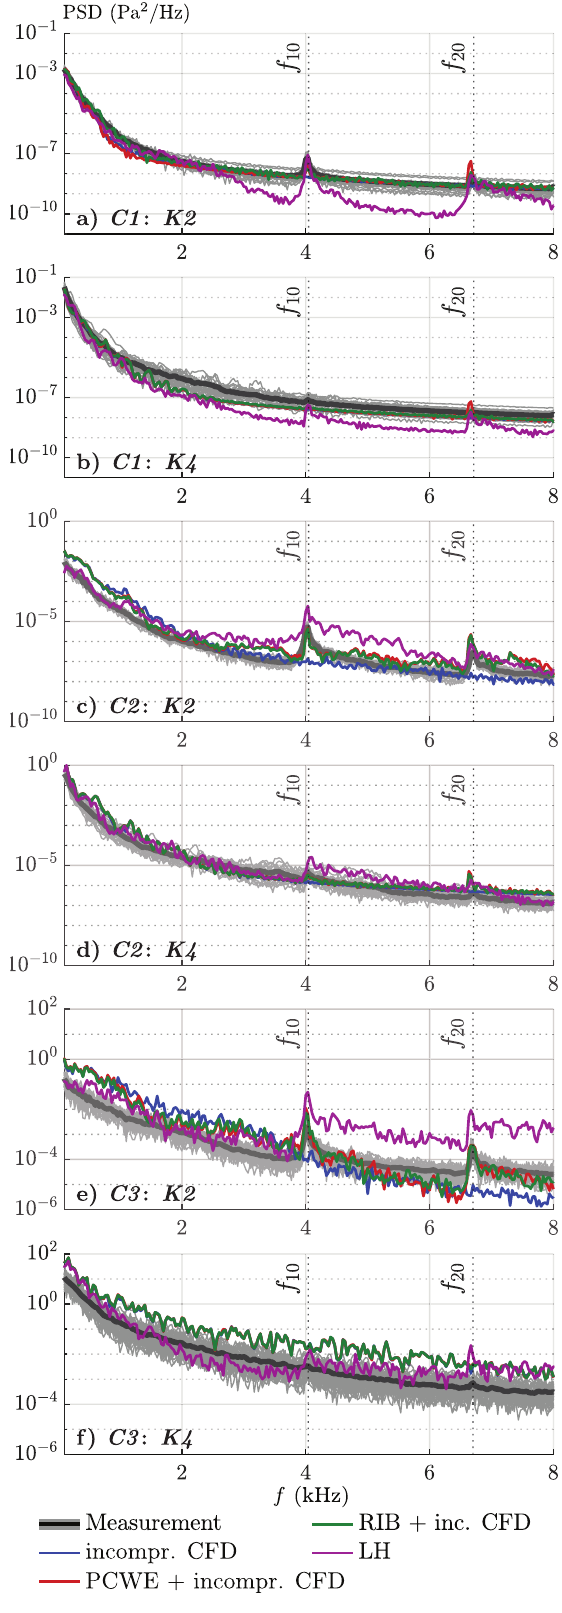
Figure 13. PSDs of the wall pressures of C 1, C 2, and C 3 at positions upstream ( K 2) and downstream ( K 4) of the ori fi ce.